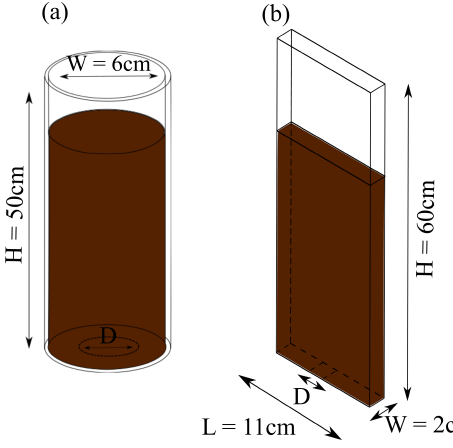
Figure 1. Geometry of the axisymmetric silo (left) and the 2D silo